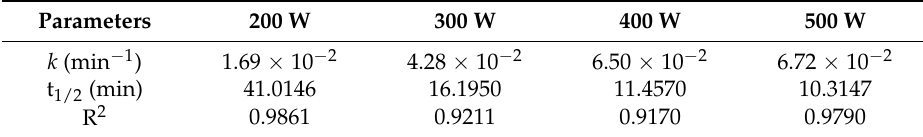
Figure 2. Kinetic analysis of Pg-3-glu during ultrasonic treatment. Table 1. Degradation kinetics parameters of Pg-3-glu exposed to ultrasonic waves.